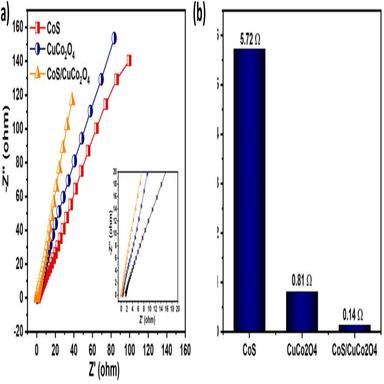
EIS analysis; (a) Nyquist plot and RES for CoS, CuCo2O4, and CoS-CuCo2O4.